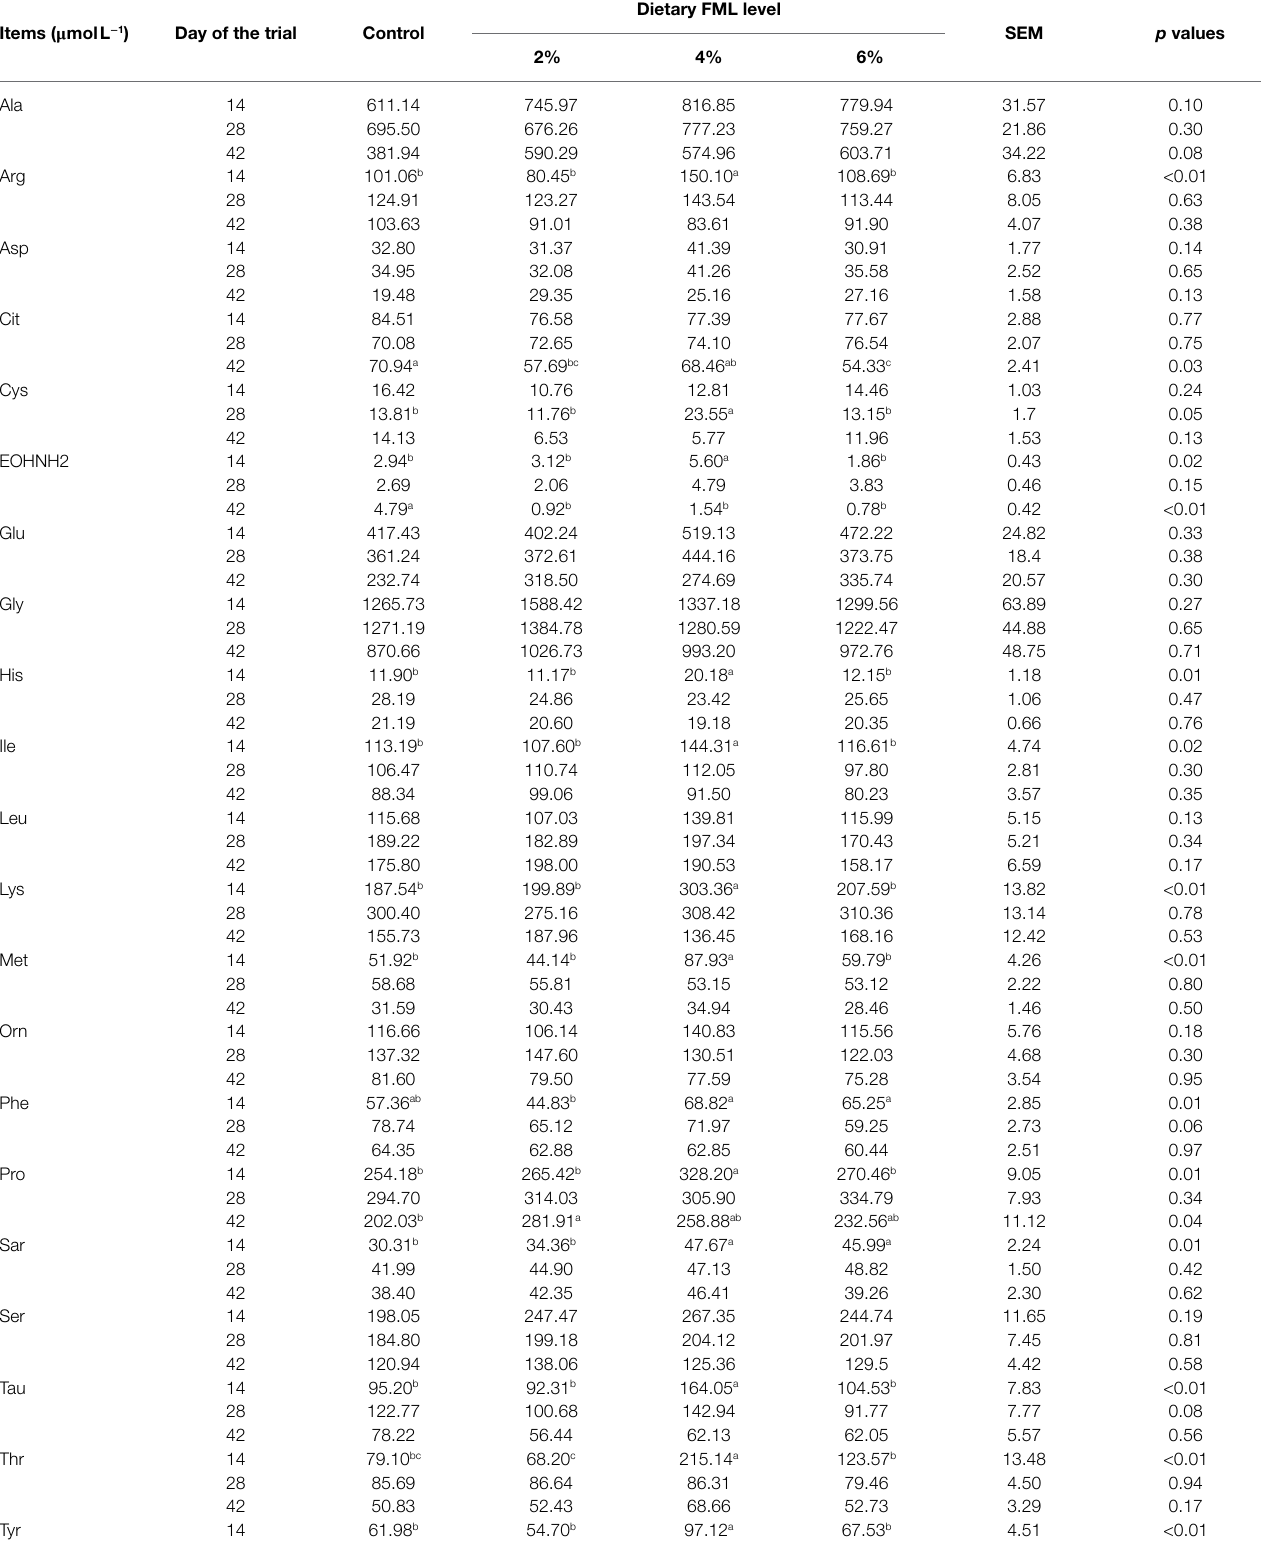
TABLE 3 | Effects of dietary supplementation with fermented Mao-tai less (FML) on plasma concentration of free amino acids in weaned piglets.